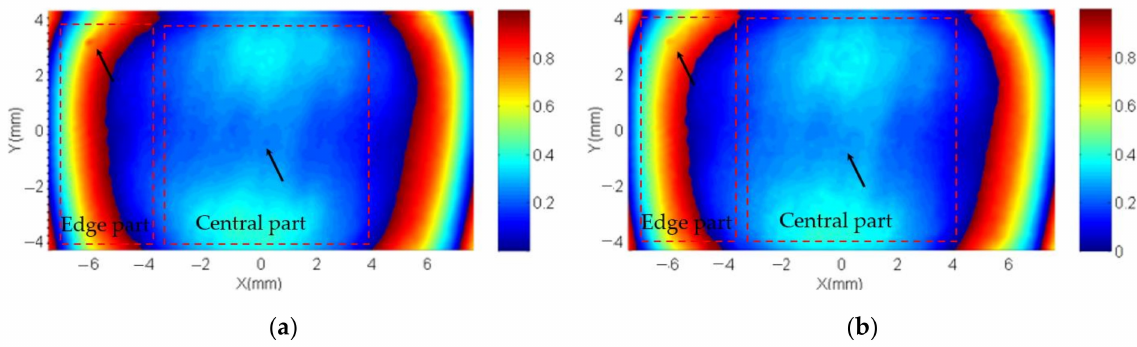
Figure 13. The wrapped inherent phase of LCoS-SLM. ( a ) The initial wrapped phase and ( b ) corrected wrapped.